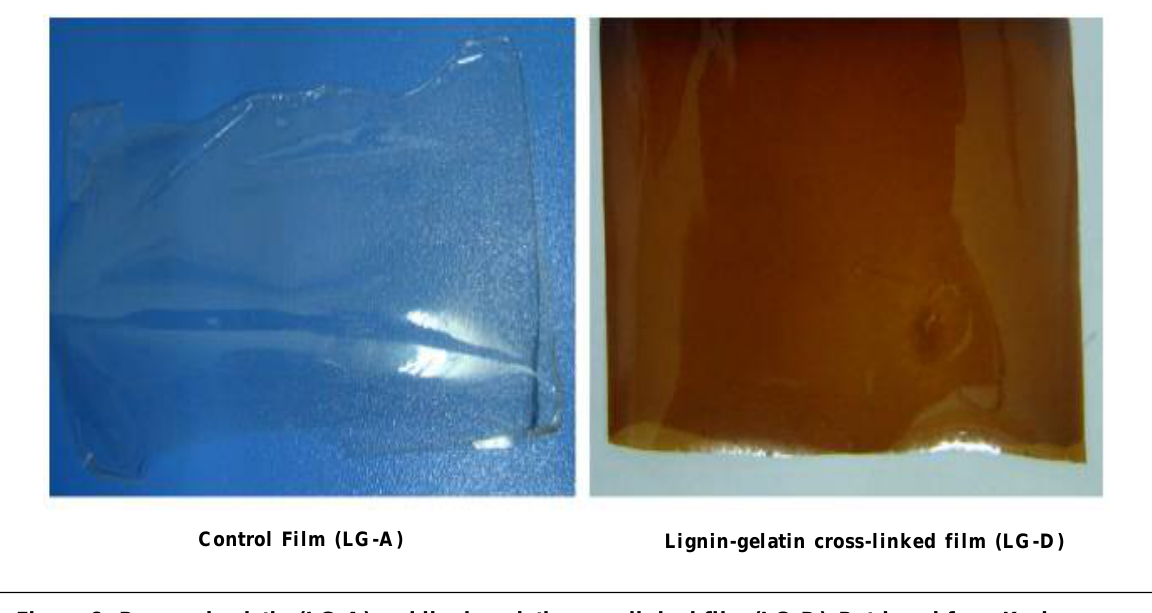
Figure 6: Prepared gelatin (LG-A) and lignin-gelatin cross-linked film (LG-D). Retrieved from Keshaw et al., 2016